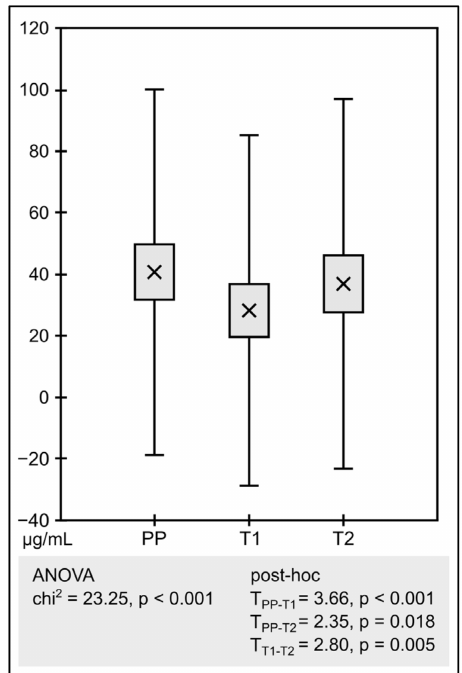
Figure 1. Analysis of MICs (PP—pure powder, T1—tablet 1, T2—tablet 2). The graph com- pares the mean of the determinations. The boxes show standard error and the whiskers shows standard